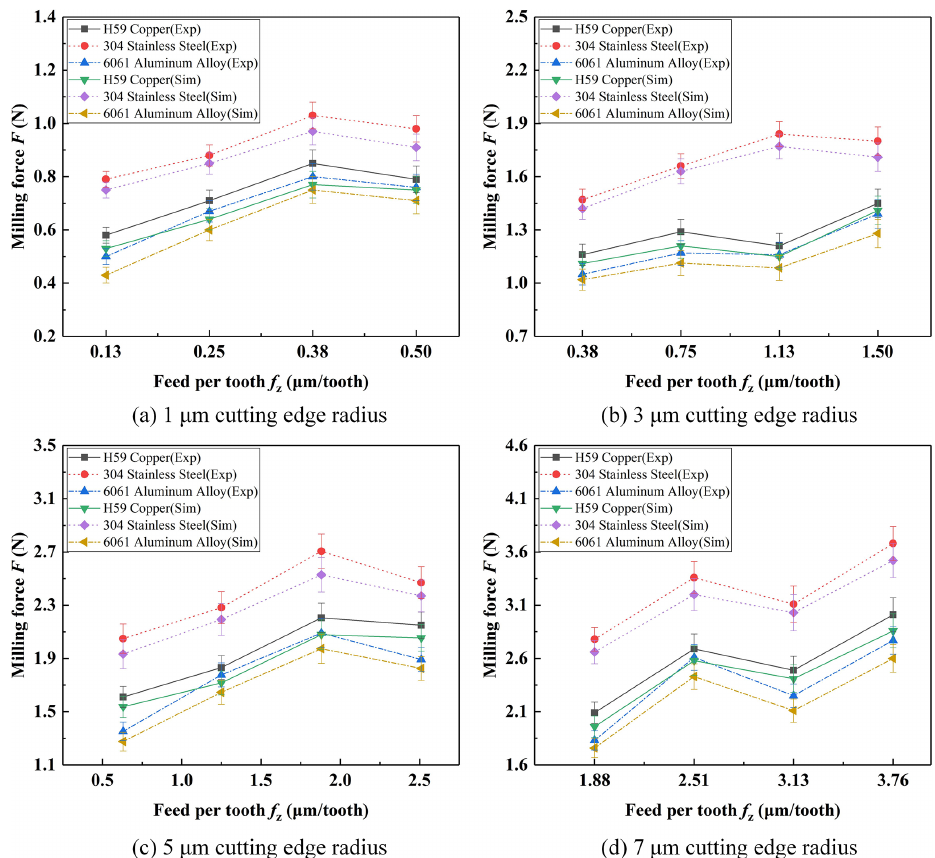
Figure 4. Milling force results of the peripheral cutting edge (process no. 2). Table 6. MUCT-simulated results of the end cutting